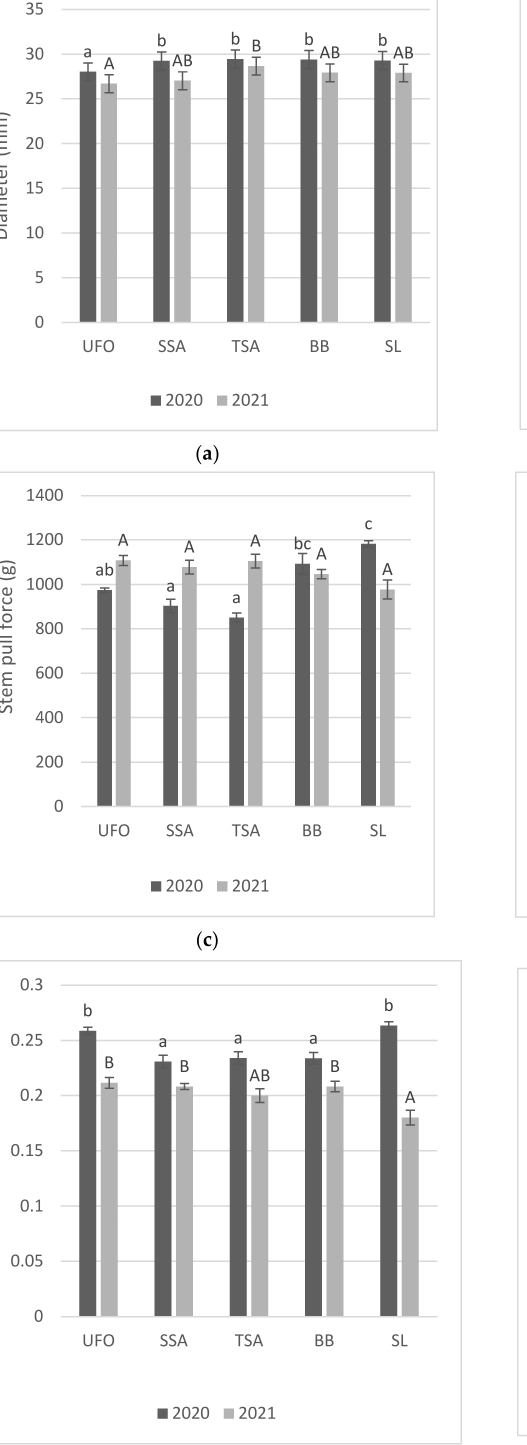
Figure 2. Training system effects on various fruit quality characteristics of sweet cherry cultivar ‘Kordia’ for the 2019–2020 (black) and 2020–2021 (grey) seasons. Bonferonni adjustments were made for multiple hypothesis testing between fruit quality characteristics between training systems, within each season as indicated by lower- and upper-case letters above means. Different letters above the means indicate significant difference ( p ≤ 0.05) between training systems within the same season. Error bars represent one standard error for each training system and n = 6 for each system in a